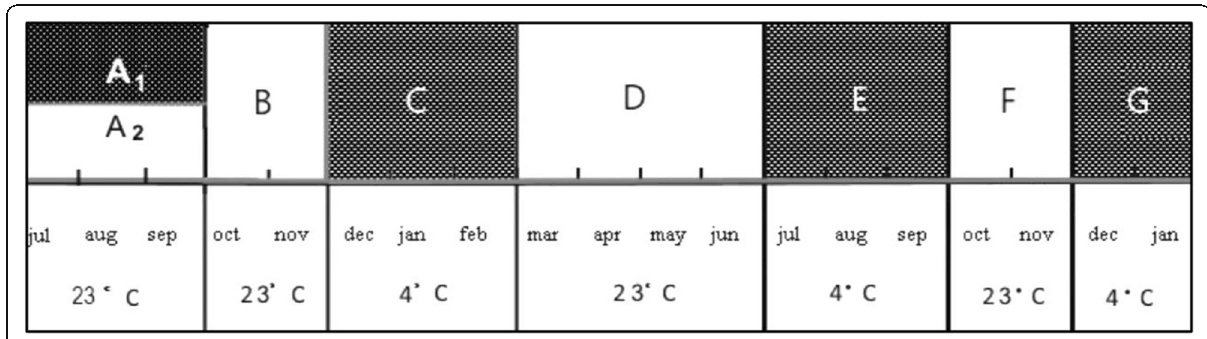
Fig. 1 Scheme of experimental timing (July 2019 – January 2021) followed in the study of O . militaris seedlings arising from immature seeds. # From the top to the foot of the dark and white rectangles (denoting dark and light conditions, applied during the periods of the orchid seed germination, marked as A 1 , A 2, B, C, D, E, F, G) are indicated: timing of the seed cultures (months); temperature conditions